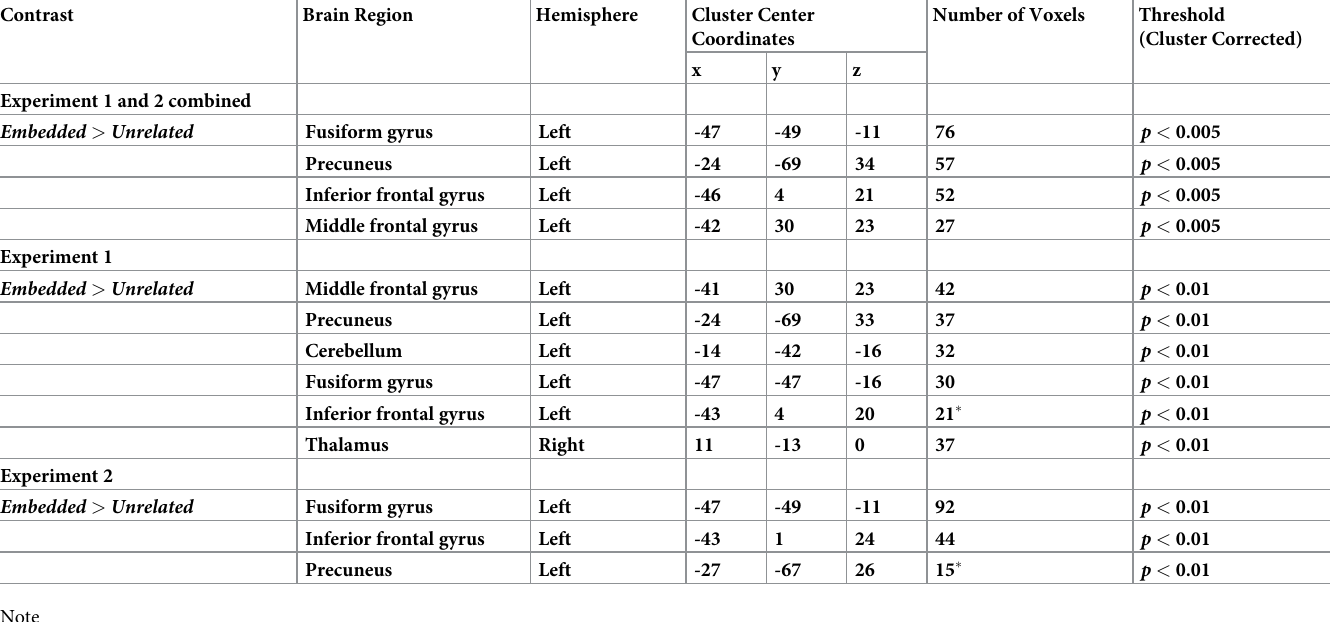
Table 1. Results of the significant activations revealed by the whole-brain